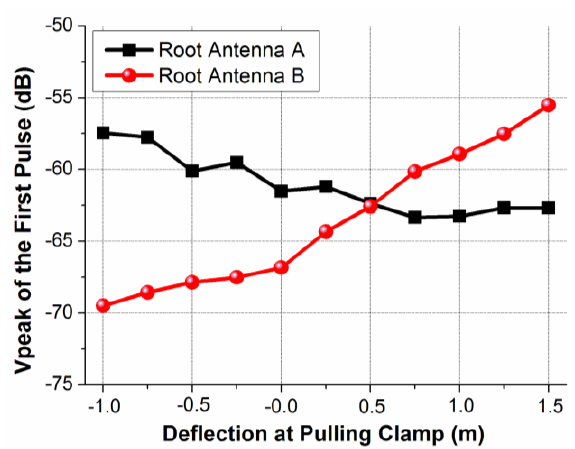
Figure 7. Peak voltages of the output first pulse under different deflections for the root antenna A and the root antenna B.